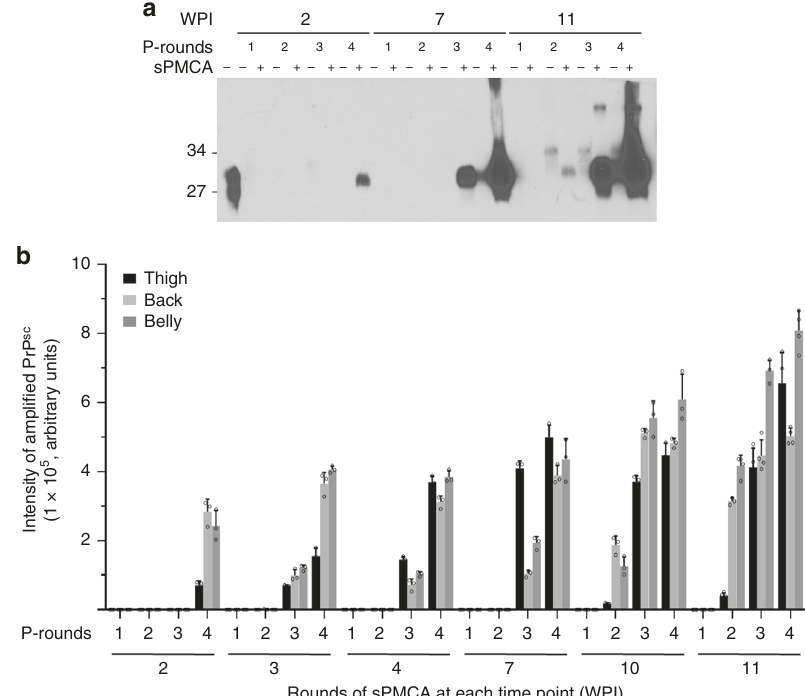
Fig. 1 Western blot analysis of skin PrP Sc ampli fi ed by sPMCA. a Representative western blot analysis of ampli fi ed PrP Sc from the thigh skin of hamsters killed at 2, 7, and 11 weeks post inoculation (wpi) of 263K prions using four rounds of sPMCA. P-rounds: number of sPMCA rounds. All samples were treated with PK at 100 µ g/ml except for the sample in the fi rst lane of the blot that was used as a non-PK treatment control. The blot was probed with 3F4. The molecular weight markers are shown in kDa on the left side of the blot. b Quantitative analysis of total western blot results on the sPMCA-ampli fi ed PrP Sc from the thigh, back, and abdominal skin tissues of infected hamsters at 2 ( n = 3), 3 ( n = 3), 4 ( n = 3), 7 ( n = 3), 10 ( n = 3), and 11 ( n = 4) wpi. Data are presented as mean ± s.d.; the error bars represent the standard deviations of the intensity of ampli fi ed PrP Sc bands measured independently at each sPMCA round, which were from three-independent